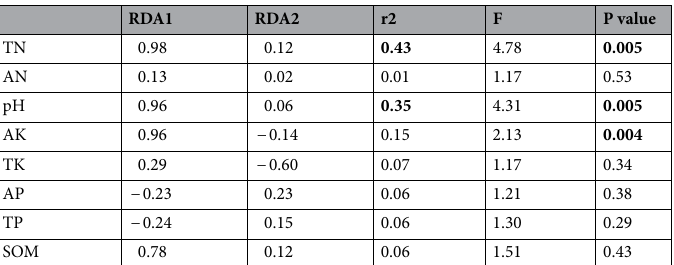
Table 2. Monte Carlo permutation test was used to determine the relationships of soil fungal community composition with soil properties in karst rocky desertification region. Values in bold indicate significant associations of soil properties with soil fungal community composition. Soil organic matter (SOM), total and available nitrogen (TN and AN), total and available phosphorus (TP and AP), and total and available potassium (TK and